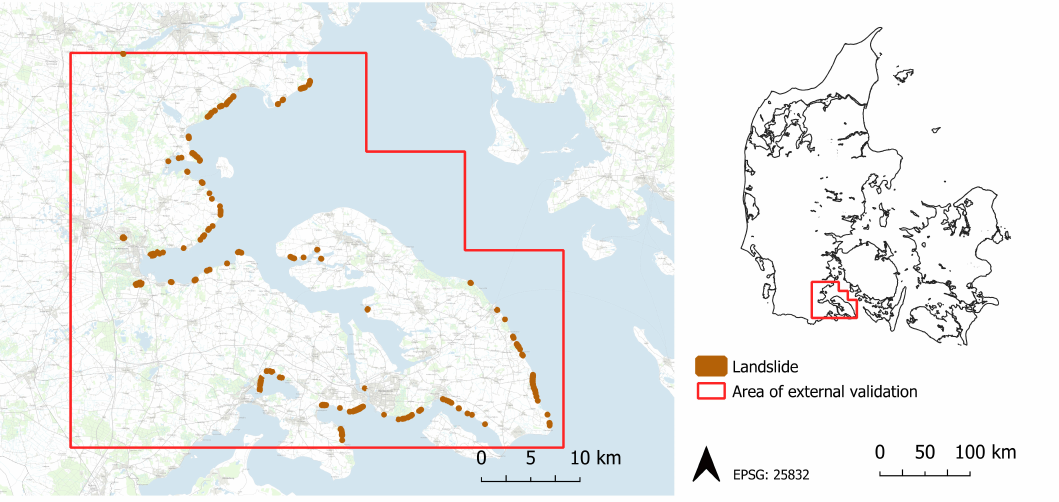
Figure 7. Area for external validation, excluding the island of